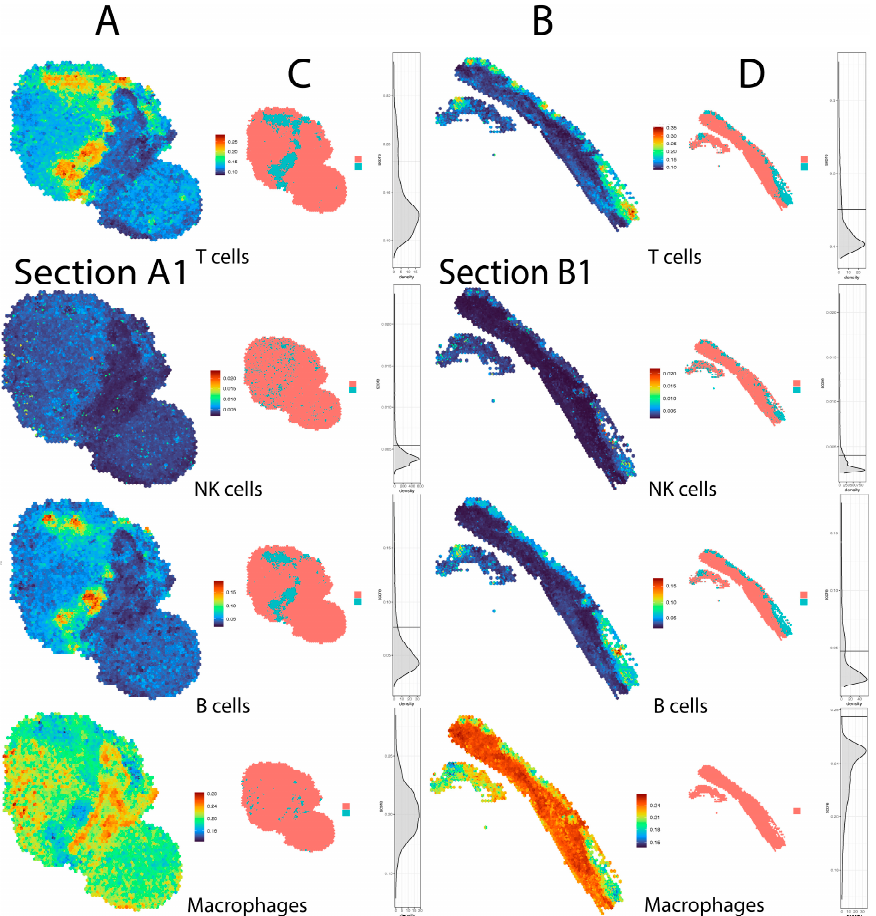
Figure 4. Increased resolution of spatial images with BayesSpace method. ( A , B ) Enhanced resolution allowed us to more precisely locate and quantify tumour-infiltrating immune cells, particularly T cells, B cells, NK cells and macrophages using the ImSig algorithm. ( C , D ) Scales and histograms represent the cut-off values assigned to elucidate the signature scores for each section and/or cell type using an outlier analysis (hampel filter)